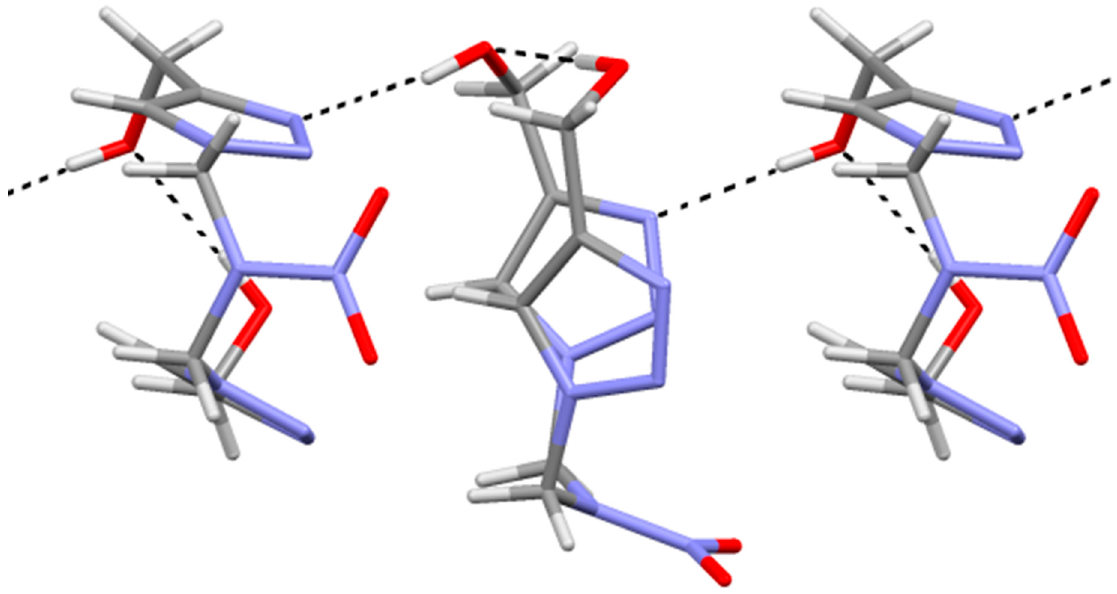
Figure 3. Hydrogen bonding in the crystal of compound 1.